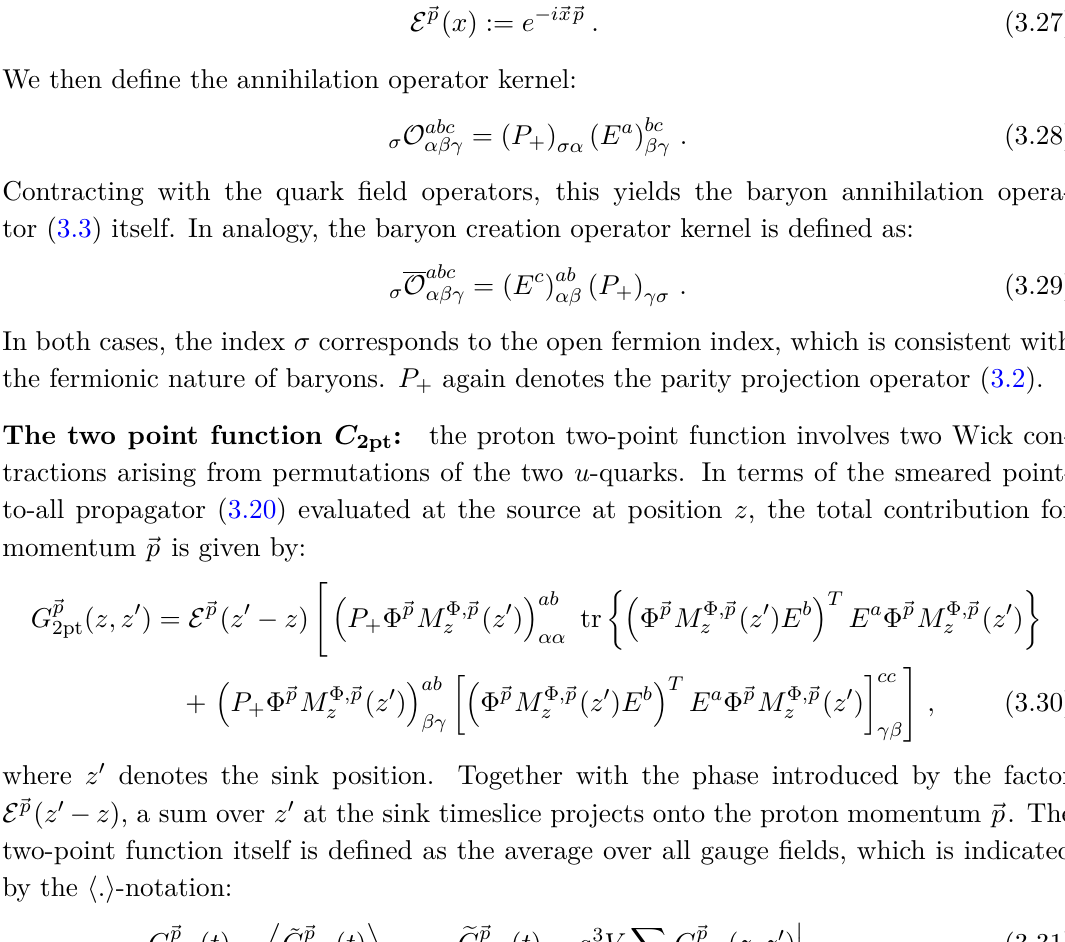
Table 2 . Number N of omitted hopping terms in the L 1 contraction for each considered operator insertion